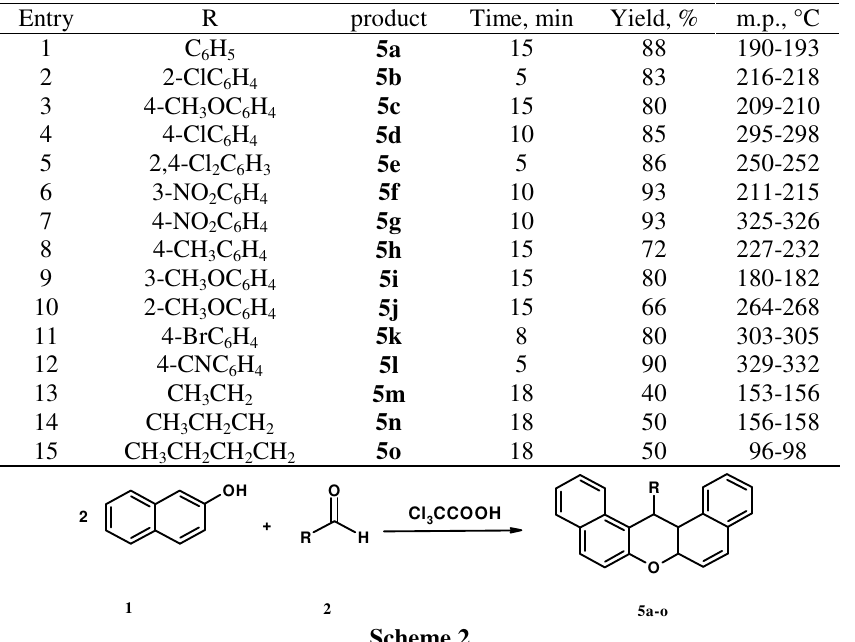
Table 2 . Synthesis of 14-alkyl- or aryl-14 H